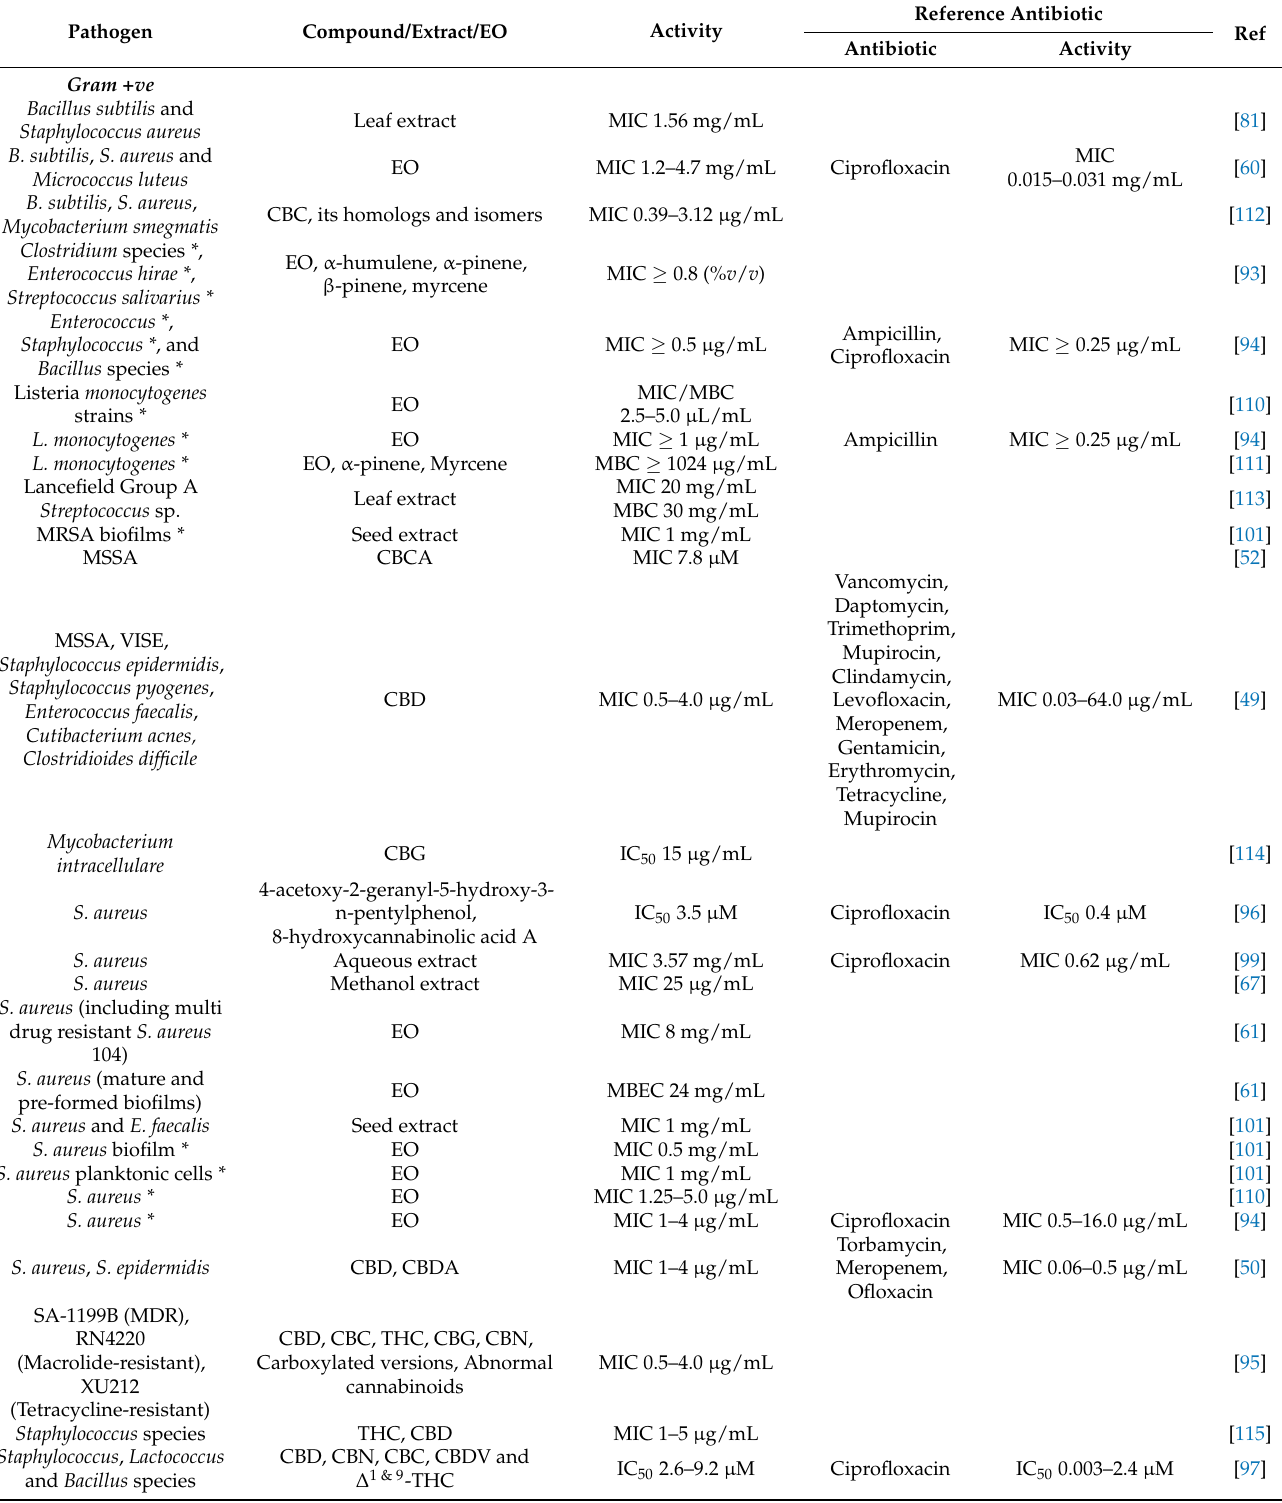
Table 2. Activity of cannabinoids and C. sativa against pathogens other than those on the WHO’s priority list (* collected from foods or food